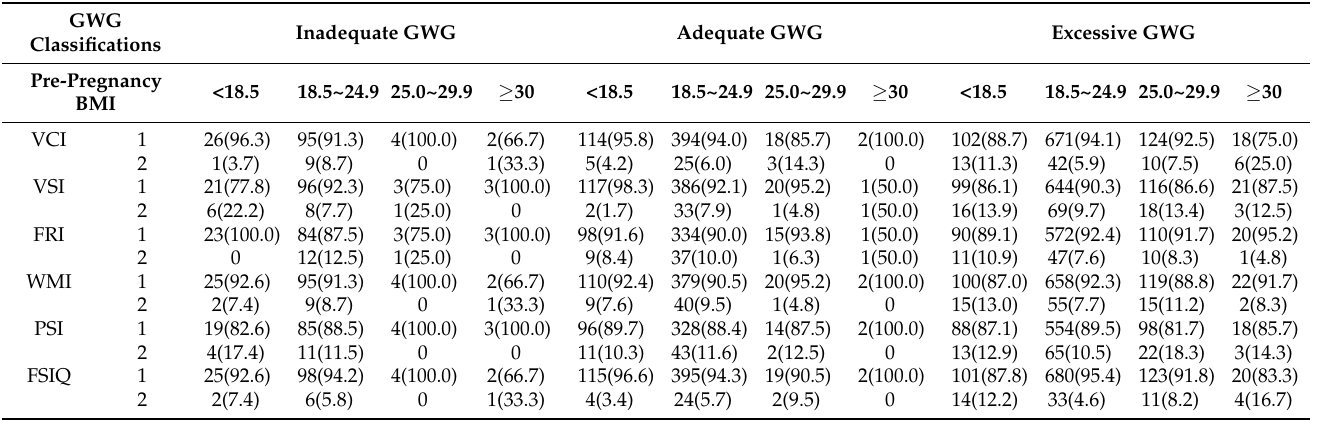
Table 3. Distribution of children’s cognitive ability under different maternal pre-pregnancy BMI in different GWG classifications [ n (%)].